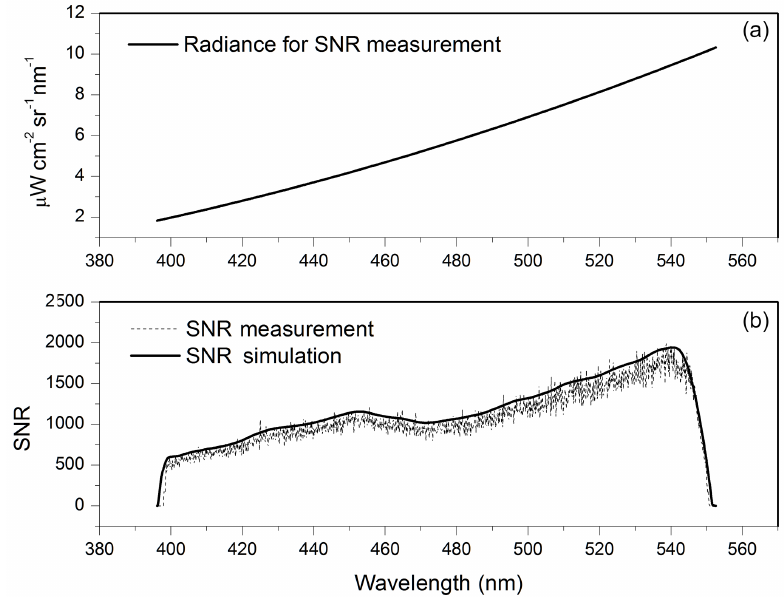
Figure 14. Panel (a) presents the radiance of the integrating sphere system for SNR measurement of VIS1 in the laboratory. Panel (b) presents the results of measured SNR (solid line) and simulation result (dotted line) for the radiance of panel (a) with an integration time of 2s and a binning factor of 4. The measured SNR in the wavelength range 460–500nm lowers because a filter of this range is placed in front of the slit 11 to make sure that the detectors are not saturated in the case of clouds. There is an overlap band at the end of the channel, which is due to the optical features of the color separation filter. In addition, there are 24 dark pixels at the end of the channel when the measured SNR is approximately zero.